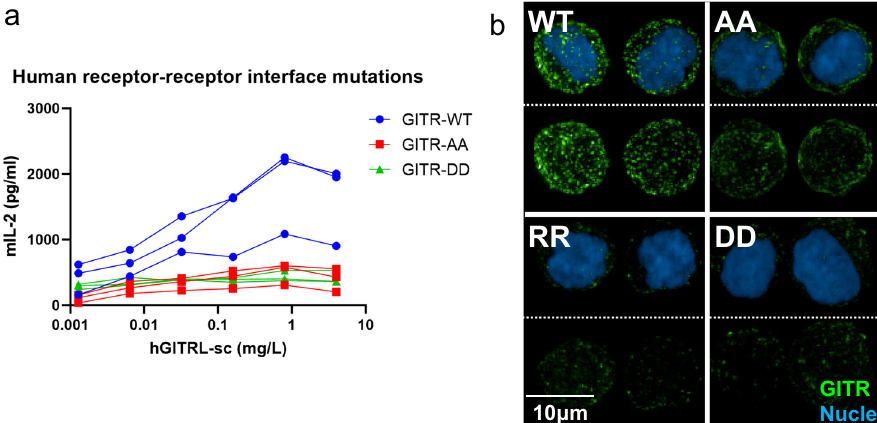
Fig. 7 Human receptor mutations which disrupt the receptor – receptor interface. a mIL-2 secretion upon hGITRL stimulation with hGITR cell lines expressing WT GITR, AA, and DD variants ( n = 3; independent experiments performed three times). b WT cell line (top left) shows distinct puncta with fl uorescently labeled hGITRL-sc trimer staining, while AA cell line (top right) shows reduced receptor binding and clustering. DD and RR (bottom panels) show near complete loss of receptor staining with hGITRL-sc trimers. This imaging experiment was performed once, cells plated in duplicate. Source data are provided as a Source Data fi